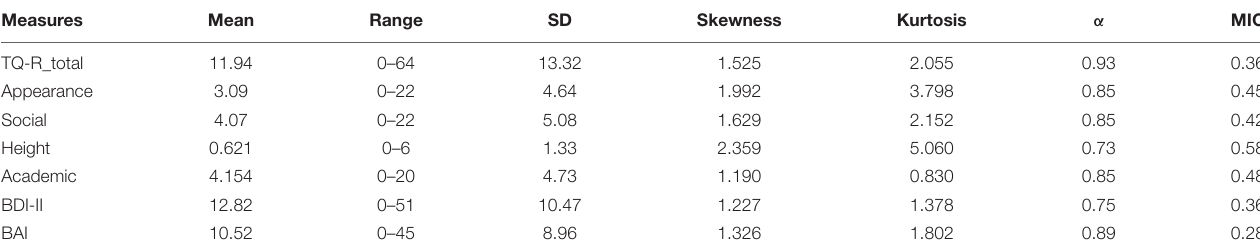
TABLE 1 | Descriptive statistics of TQ-R, BDI-II, and BAI variables. Measures Mean